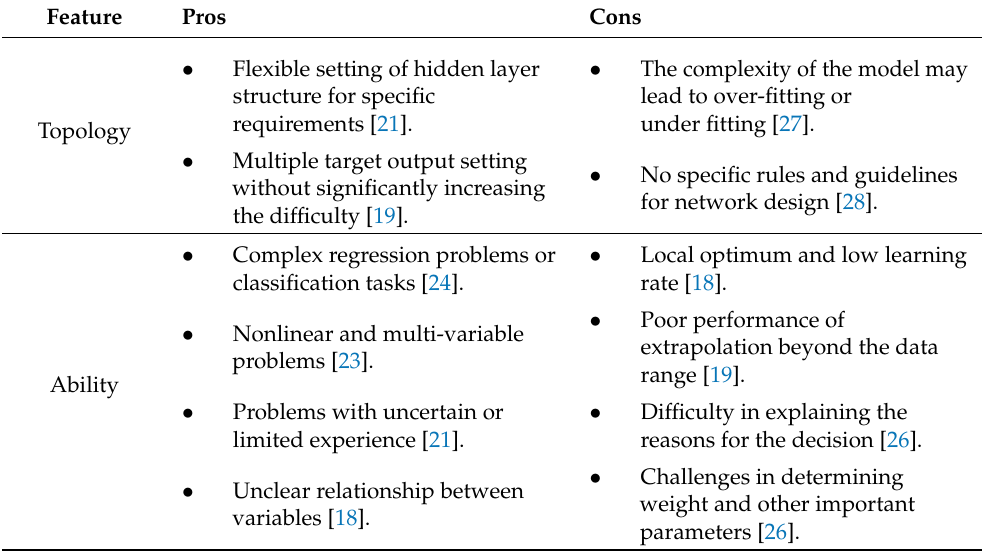
Table 1. Pros and Cons of the ANN. (Adapted from